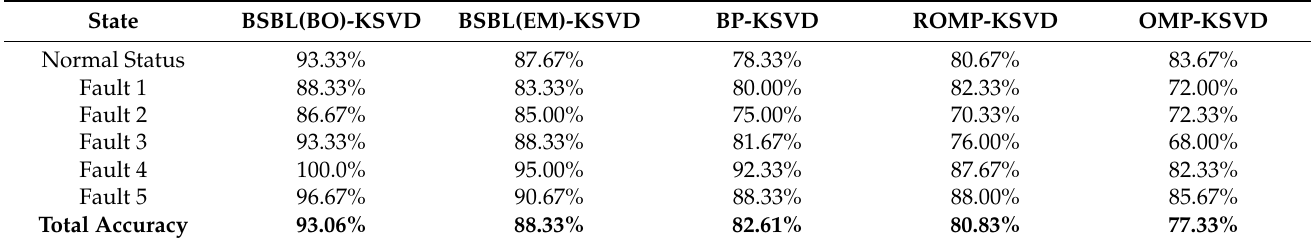
Table 4. When CR = 0.5, the comparative analysis of fault classification of different compression and reconstruction methods.